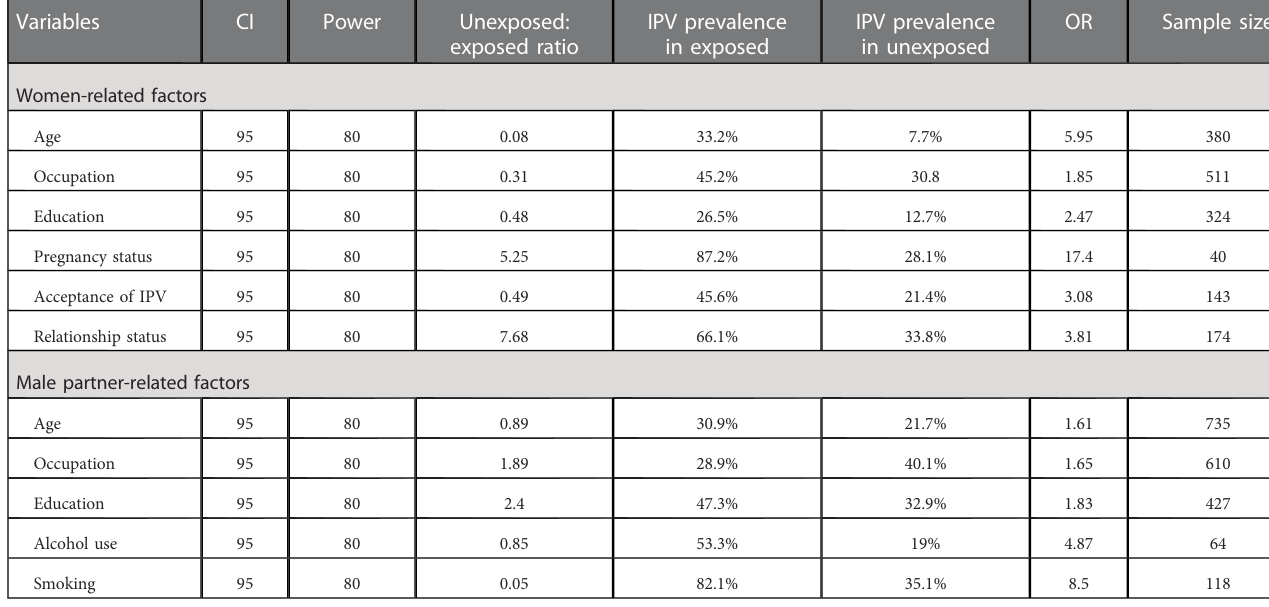
TABLE 2 Sample size calculation based on factor variables to assess IPV prevalence among women of reproductive age during the COVID-19 pandemic in Debre Berhan, 2021 G.C.